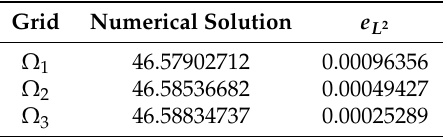
Table 1. Numerical prices and errors on different grids for one-asset option at x = 100. Here, u ( x , T ) =